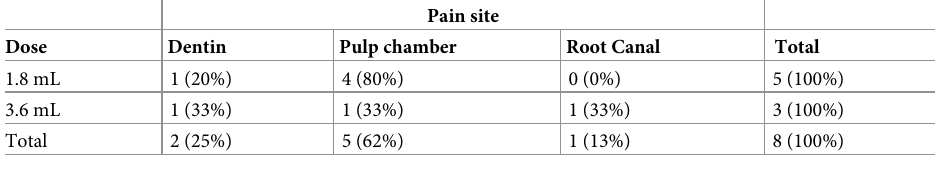
Table 3. Frequency and percentage of pain site distribution as reported for the 1.8 mL and 3.6 mL doses after complementary periodontal ligament